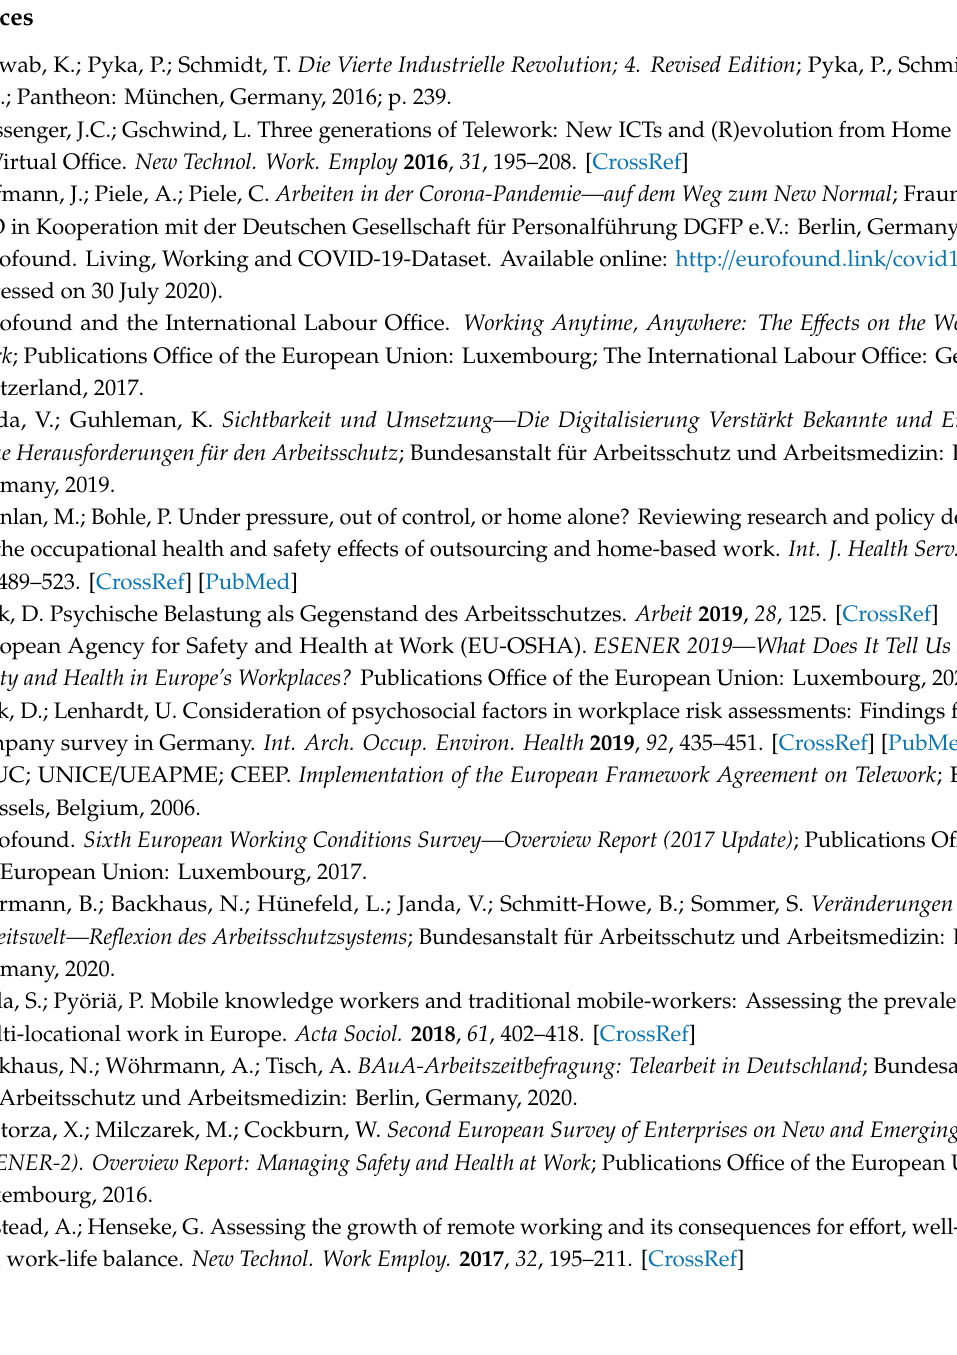
Table S1: A cross-table for the interrater analysis. Table S2: Research projects referring to new ways of work within the project line